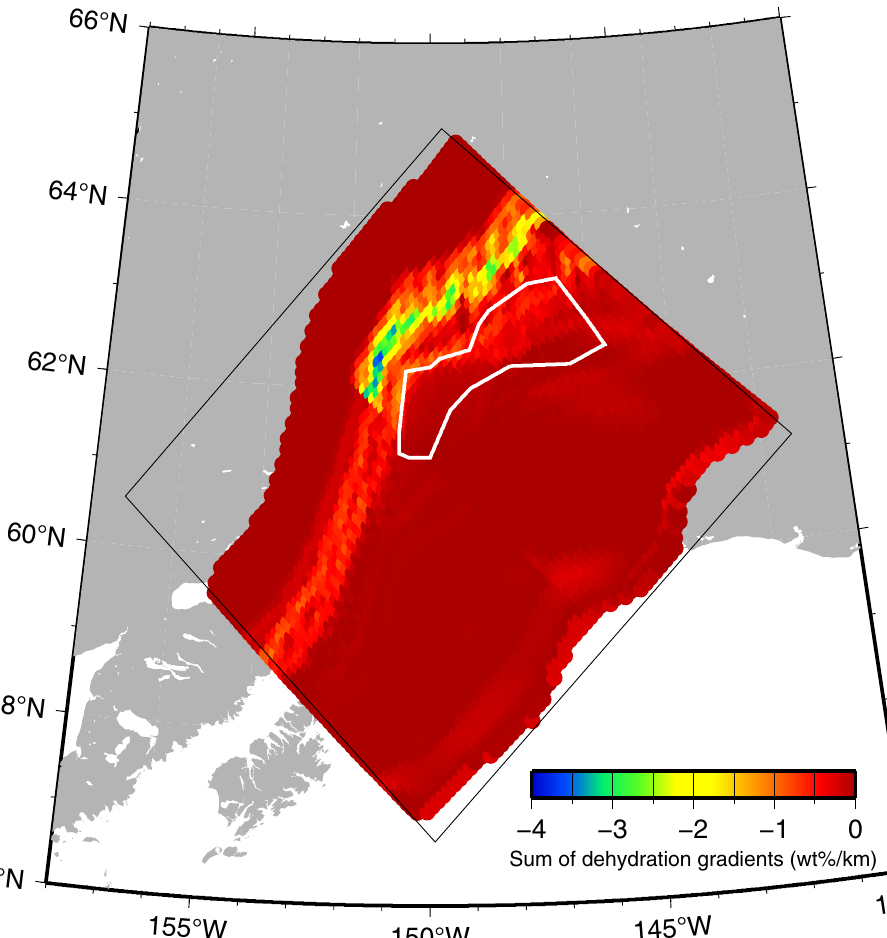
Figure 5. The vertical sum of the dehydration gradients from the slab surface to the slab Moho. The thin black box represents the model region. The vertical sum is plotted only in the region where the depth of the slab surface is shallower than the bottom of the model (200 km) and where the temperature is higher than 200 °C, for which values of phase diagram data exist. The white line indicates the area where tectonic tremors occur, as shown in Fig. 1. The map was created by using the Generic Mapping Tools (GMT) 25 (version: GMT 4.5.7, URL link: https:// www. gener ic- mappi ng- tools. org/ downl